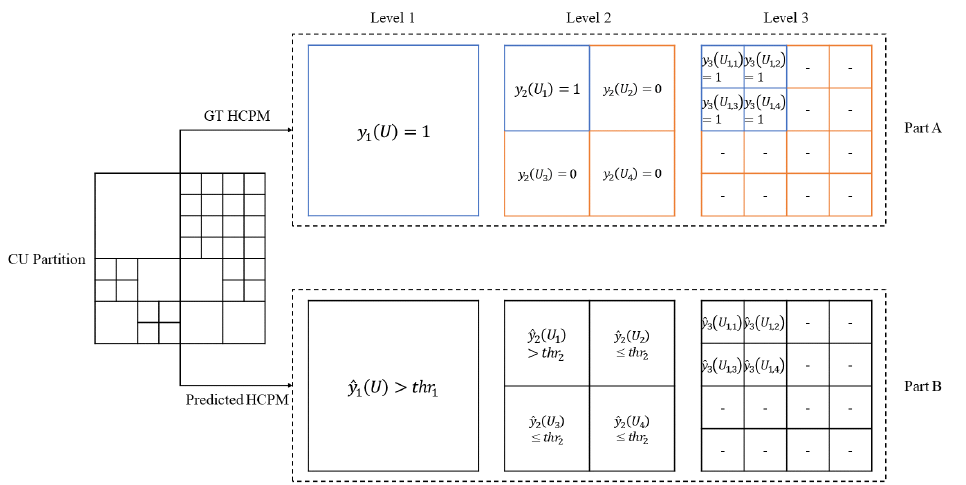
Figure 3. Structure of HCPM. The truth partition is shown in Part A. y 1 ( U ) , y 2 ( U i ) , y 3 ( U i , j ) is the ground truth partition of each layer CUs. The subscripts i , j ∈ 1,2,3,4 are the indices of the sub- CUs split from U , U i , U i , j . In level 1, If y 1 ( U ) = 1 represents the CU will be split into four 32 × 32 CUs, conversely y 1 ( U ) = 1 represents it will not be split. In Part B, the same CTU will obtain the corresponding HCPM prediction through network process. ˆ y 1 ( U ) , ˆ y 2 ( U i ) , ˆ y 3 ( U i , j ) represents the partition prediction value of each layer, and the partition prediction is obtained by the prediction